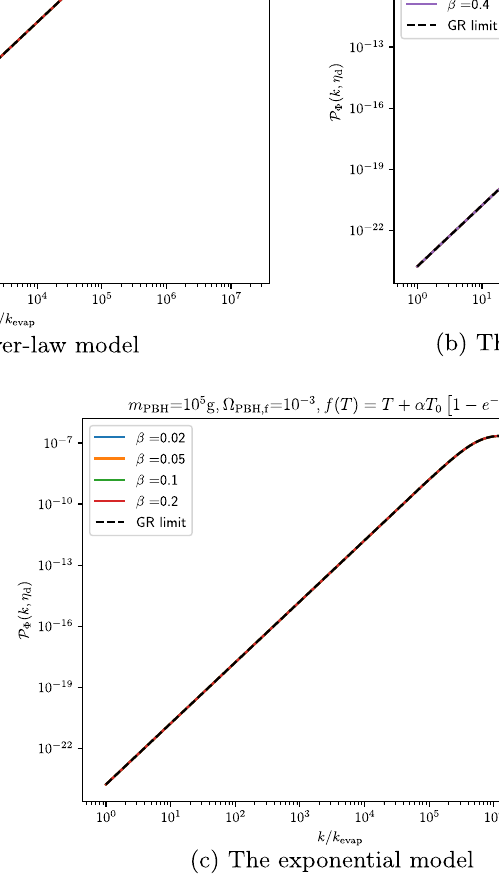
range. In all graphs we have used m PBH = 10 5 g and (cid:13) PBH , f = 10 − 3 . The dashed curves correspond to the GR